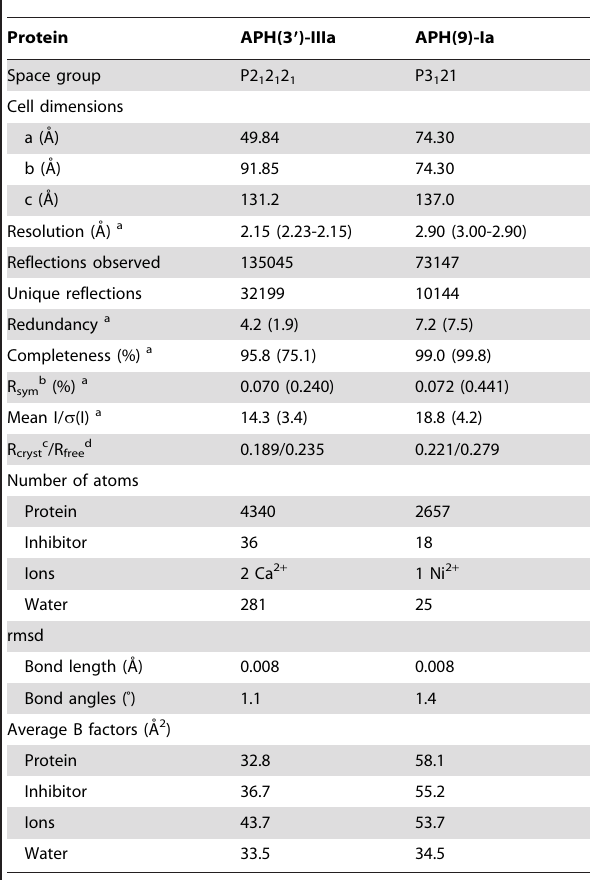
Table 1. Data collection and refinement statistics.